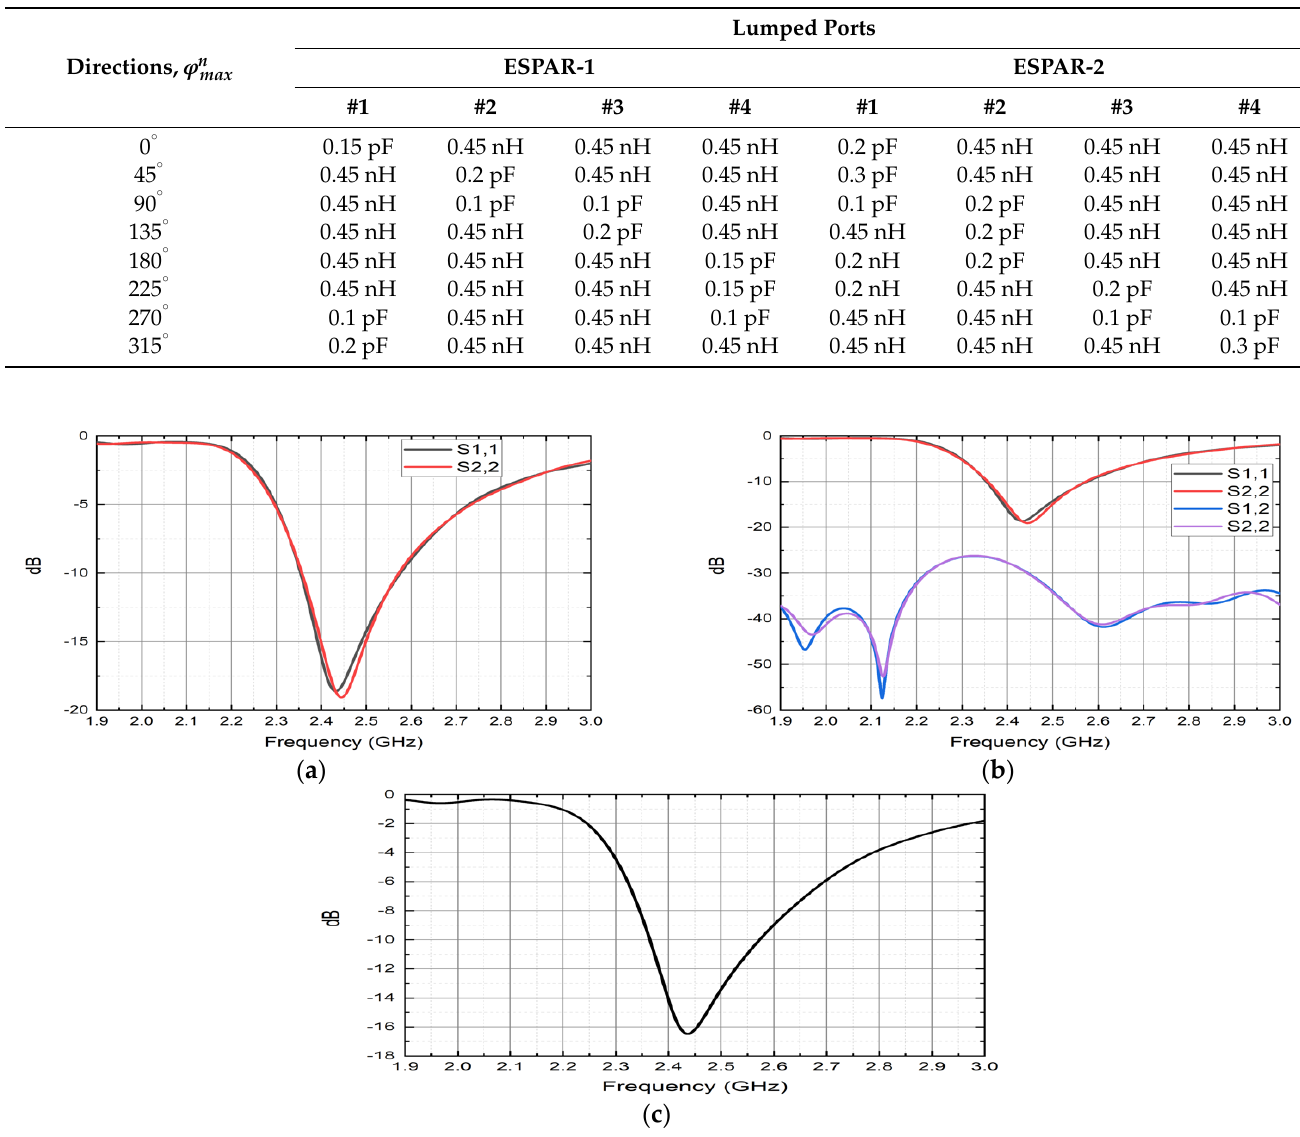
Table 4. Reactance set of the proposed 1 × 2 ESPAR array antenna.